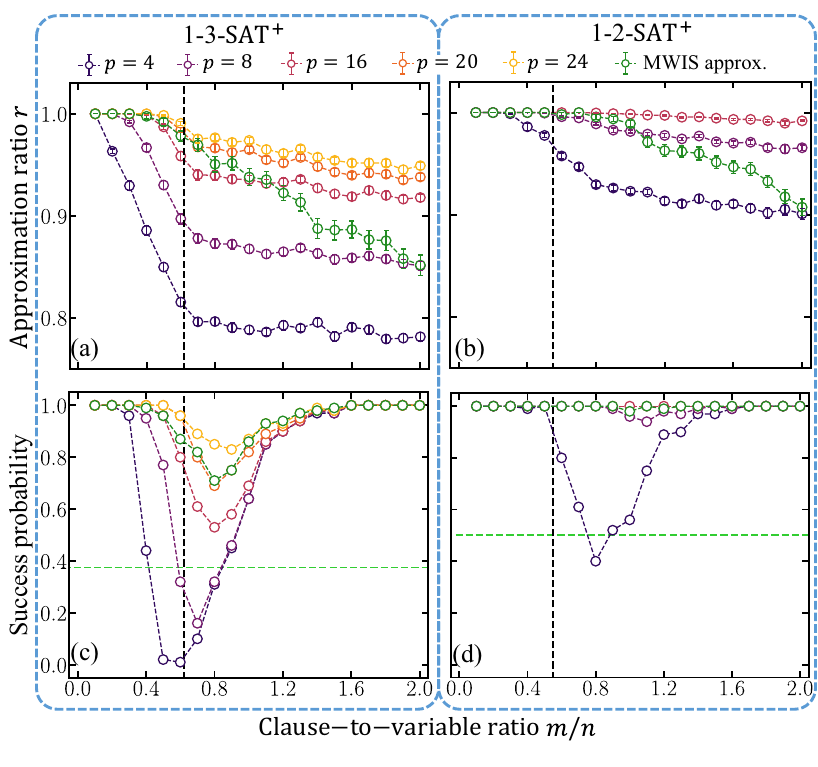
Fig. 5 Accuracy of QAOA in 1- k -SAT + . a , b Approximation ratio r of SAT clauses, ( c , d ) Success probability in determining SAT/UNSAT for 1-3- SAT + (left) (from p = 4 to p = 24) and 1-2-SAT + (right) (from p = 4 to p = 16) versus clause-to-variable ratio m / n with n = 10 variables. Green dots represent the classical approximate results through a reduction to MWIS. The horizontal light green dashed line in ( c , d ) represent the success probability of the random guess which are 3/8 and 1/2 for 1-3-SAT + and 1-2-SAT + separately. Vertical black dashed lines in all plots represent critical point of SAT-UNSAT transition. All results and error bars are estimated over 100